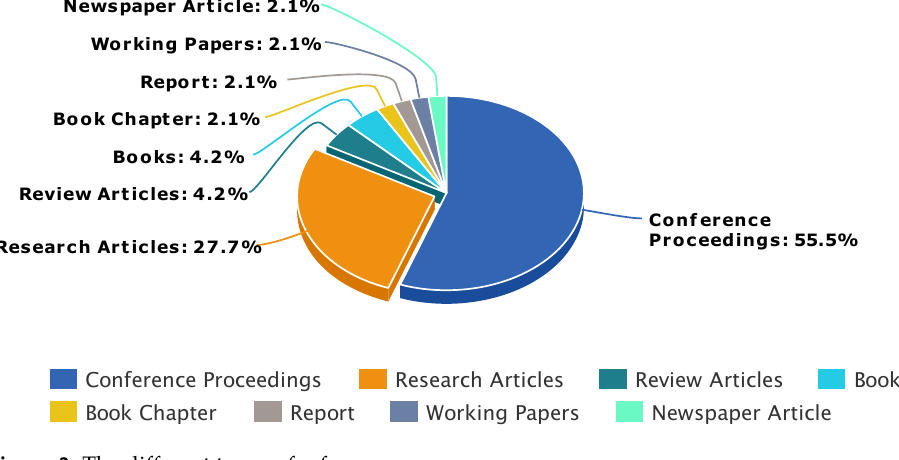
Figure 3. The different types of